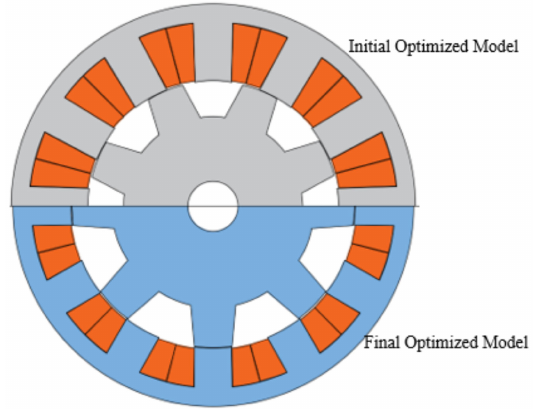
optimized models, respectively.